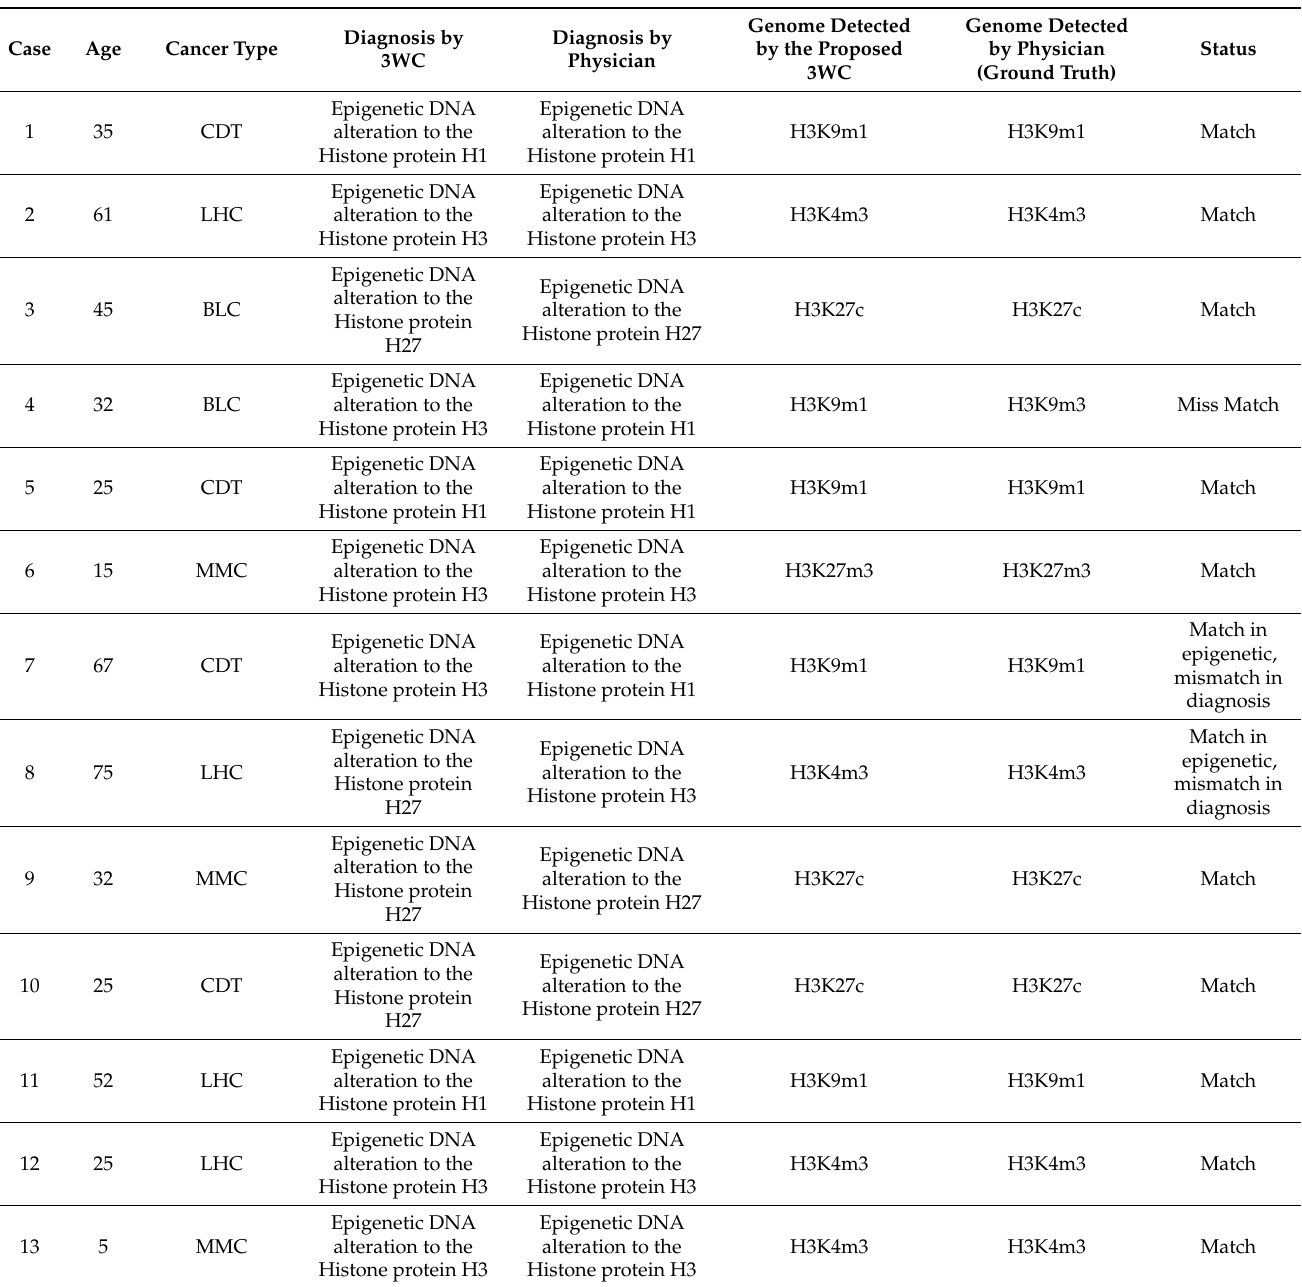
Table 2. Experimental results as related to ground